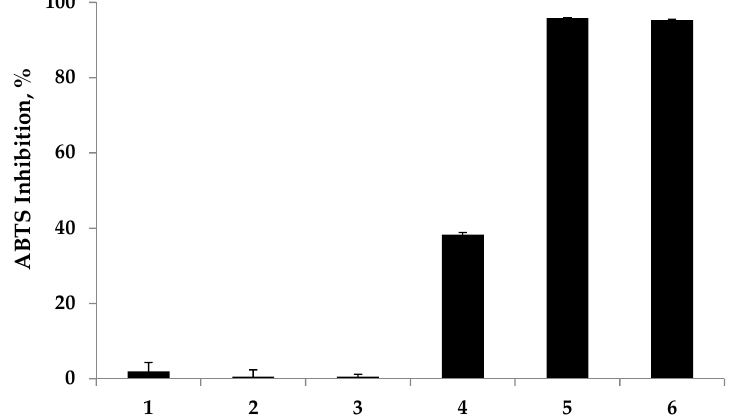
Figure 6. Radical scavenging capacity of the prepared antioxidant hydrogels against 3-ethylbenzothiazoline-6-sulfonic acid (ABTS) free radicals. The amount of ascorbic acid was 0.85 μ mol. Legend: 1 = poly(2-hydroxyethyl methacrylate) (p(HEMA)); 2 = low-methacrylamide chitosan hydrogel (MC-H); 3 = high-MC-H; 4 = low-MC-gallic acid (GA); 5 = high-MC-GA; 6 = ascorbic acid.